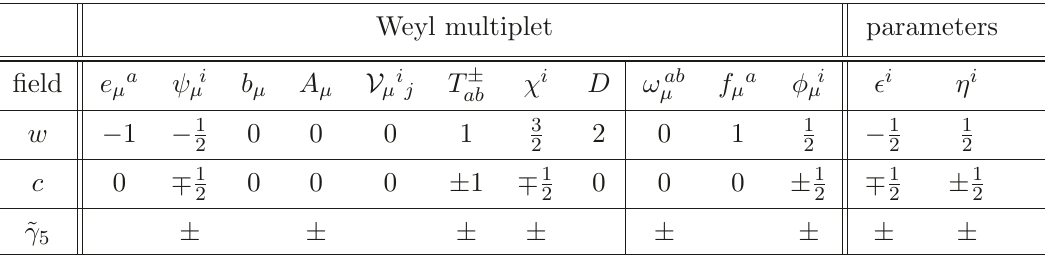
Table 2 . Weyl weights w and chiral SO(1 , 1) weights c , chirality/duality ˜ γ 5 of the spinors and the antisymmetric tensor field for the 4 D Euclidean Weyl